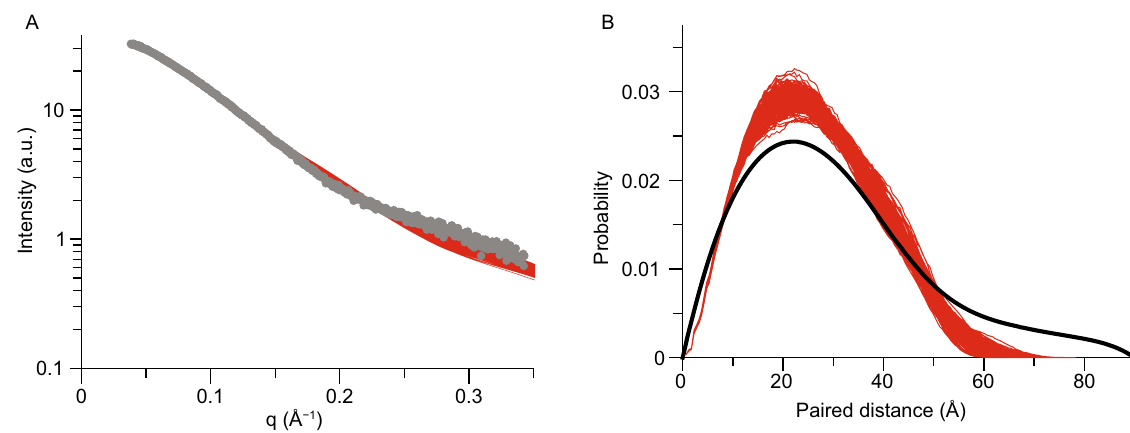
Figure 4. Analysis of METTL3 ZFD structure with small-angle X-ray scattering. (A) Comparison between the experimental (shown as gray dots for the truncated version of ZFD for residues 258 – 338) and calculated (shown as red lines) scattering pro fi les. The scattering curves are calculated for all 25 conformers in the bundle. (B) Comparison between the experimental (shown as black line) and calculated (shown as red lines) paired distance distribution P(r) functions. The P(r) pro fi le suggests that the C-terminal tail of the ZFD likely interconverts between open and closed